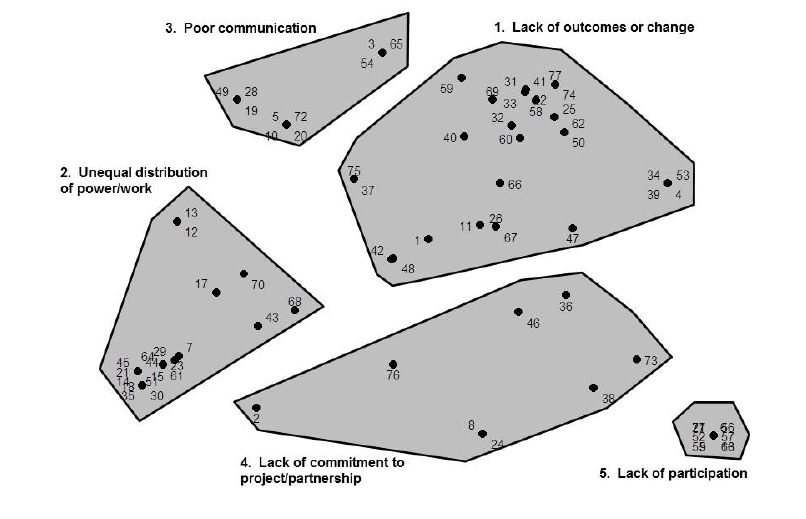
Figure 4: Characteristics